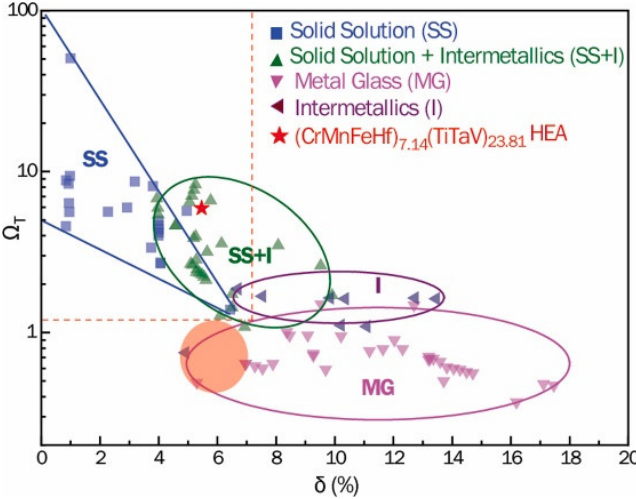
Figure 8. Ω T -δ diagram for HEAs and CrMnFeHfTiTaV HEA. The orange-filled circle marks the Figure 8. Ω T - δ diagram for HEAs and CrMnFeHfTiTaV HEA. The orange-filled circle marks the possible area, where the Ω T of (CrMnFeHf) 7.14 (TiTaV) 23.81 is located in [73]. possible area, where the Ω T of (CrMnFeHf) 7.14 (TiTaV) 23.81 is located in